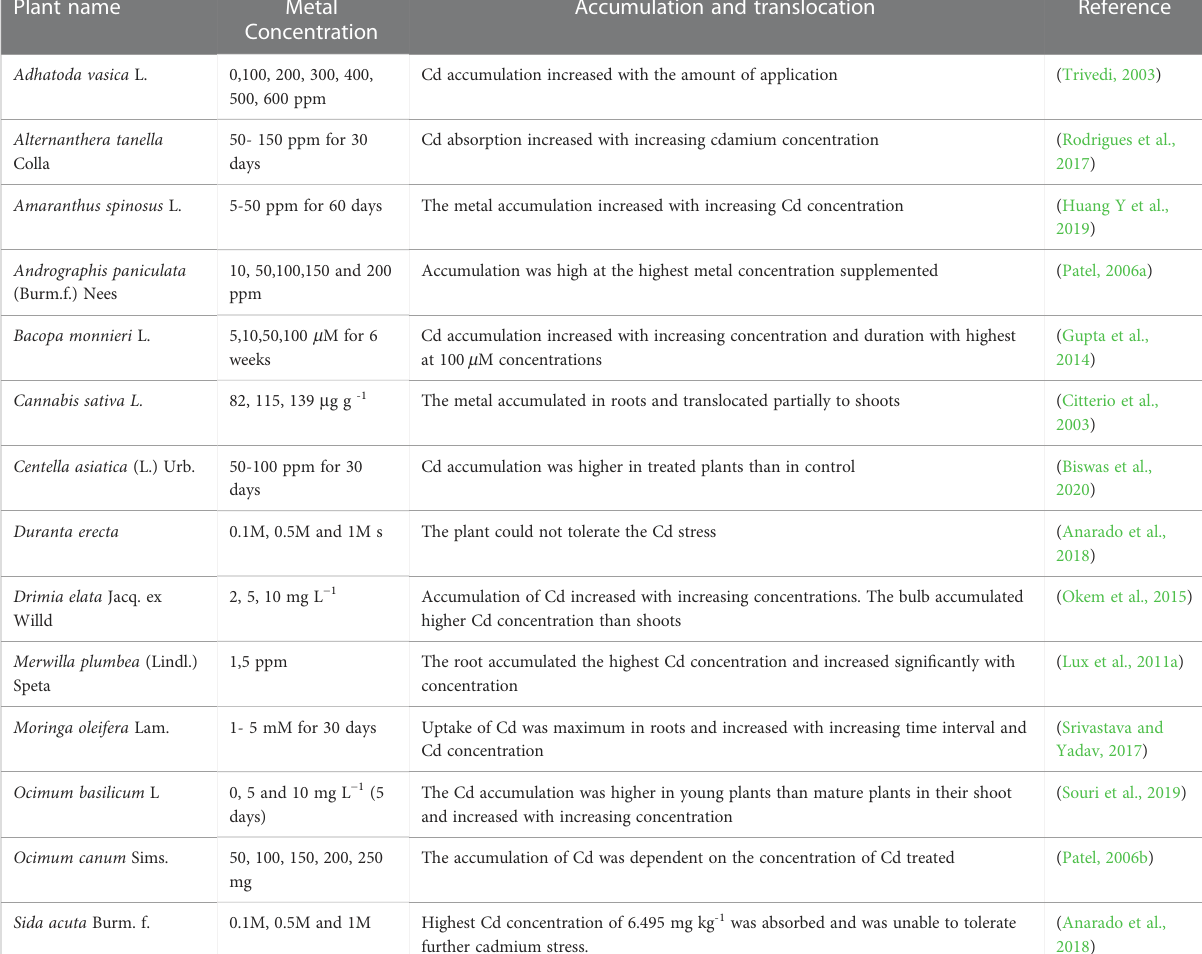
TABLE 4 Bioaccumulation of cadmium in different parts of medicinal